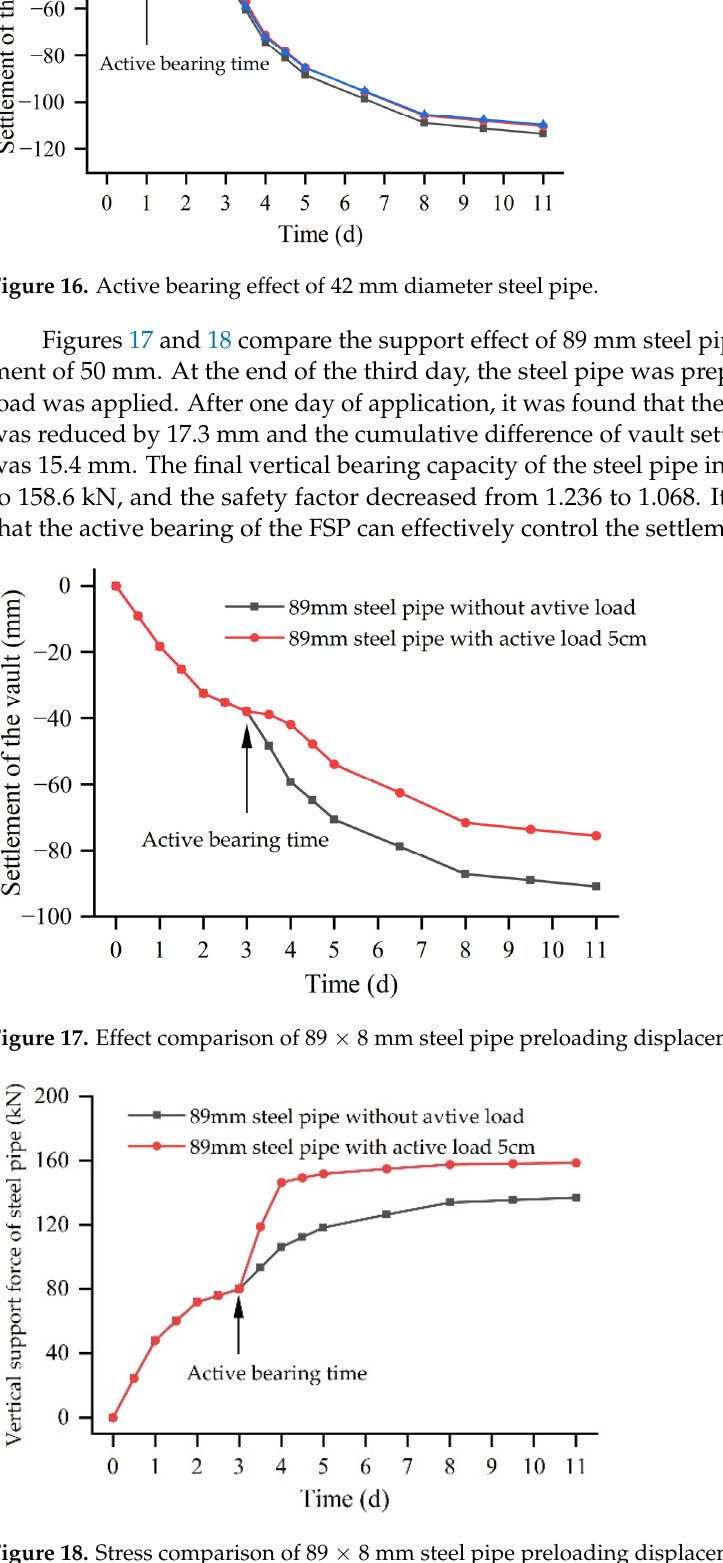
Figure 18. Stress comparison of 89 × 8 mm steel pipe preloading displacement of 50 mm.